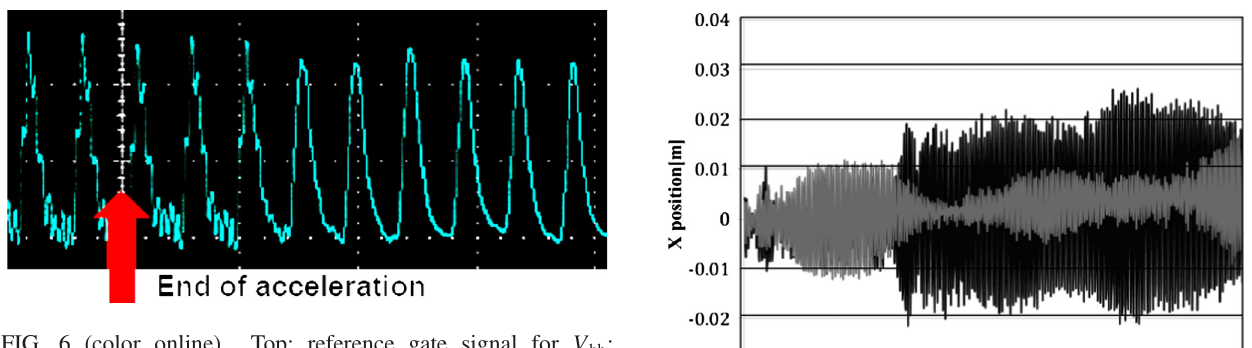
; bb FIG. 9 Temporal evolution of the beam center for plan A (grey) and plan B